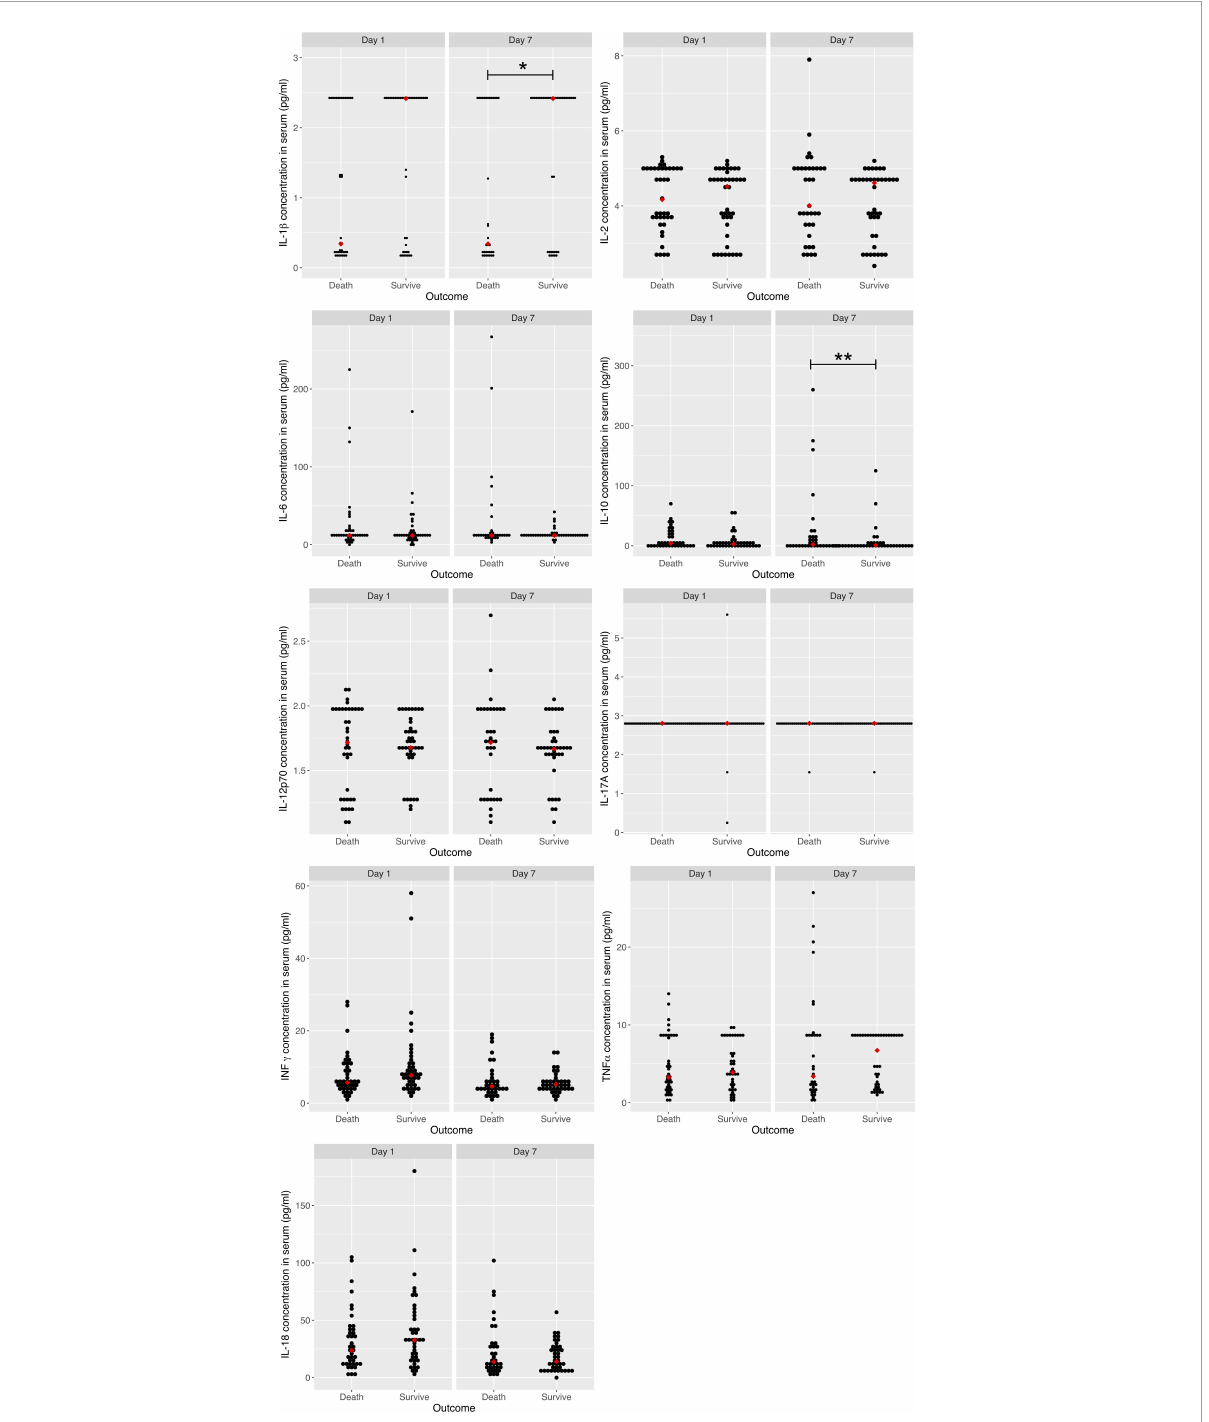
FIGURE2 Serum cytokine levels on days 1 and 7 between COVID-19 patients who died and survived. IL-1 β , Interleukin 1 beta; IL-2, Interleukin 2; IL-6, Interleukin 6; IL-10, Interleukin 10; IL-12p70, Interleukin 12p70; IL-17A, Interleukin 17A; IFN- γ , Interferon gamma; TNF α , tumor necrosis factor alpha; IL-18, Interleukin 18. * p -value < 0.05 for IL 1 β in serum cytokine concentrations on day 7 between who died and survived; ** p -value < 0.01 for IL-10 in serum cytokine concentrations on day 7 between who died and